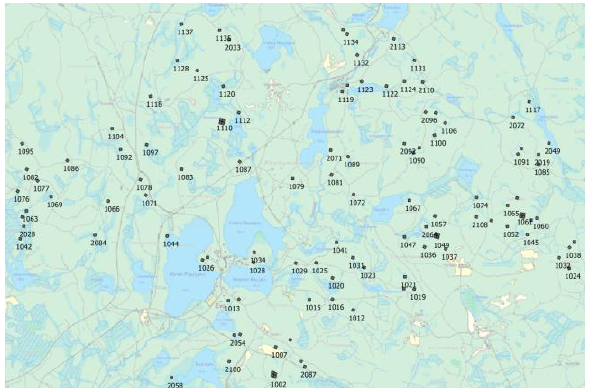
Figure 1. Locations of the forest test plots. Background